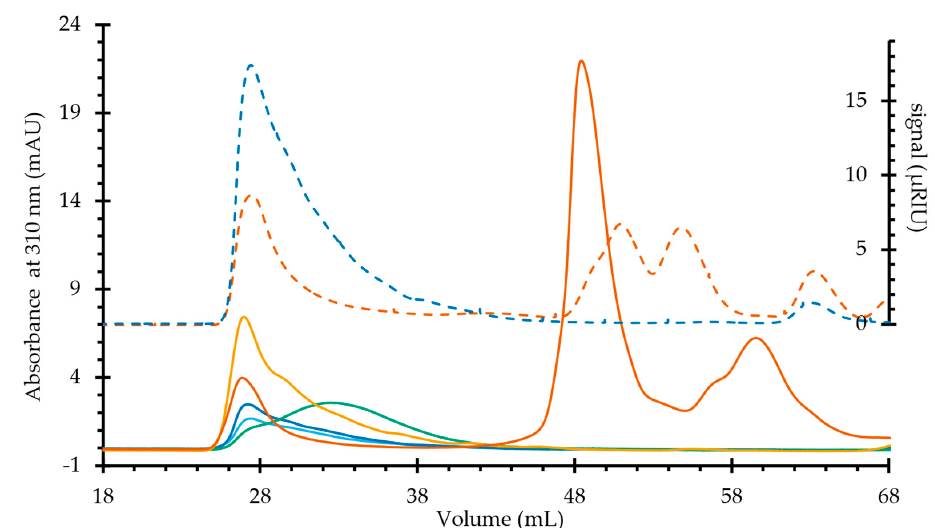
Figure A1. Size exclusion chromatogram showing the elution profile of the mucilage and IEC fractions monitored by absorption at 310 nm (solid lines), with the differential refractive index signal overlapped in broken lines. OXO M (orange), OXO N (light blue), OXO 0.2 (dark blue), OXO 0.4 (green), OXO 1.0 (yellow). Table A1. Polysaccharides’ fiber and aggregates parameters as calculated by the imaging software.